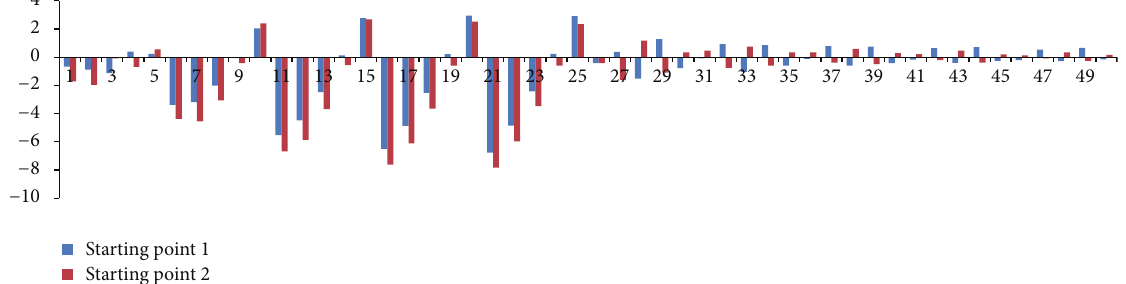
Figure 20: The MWD of “Giraffe” for the two different staring points given in Figure 9 derived from the approximation and detail signal.